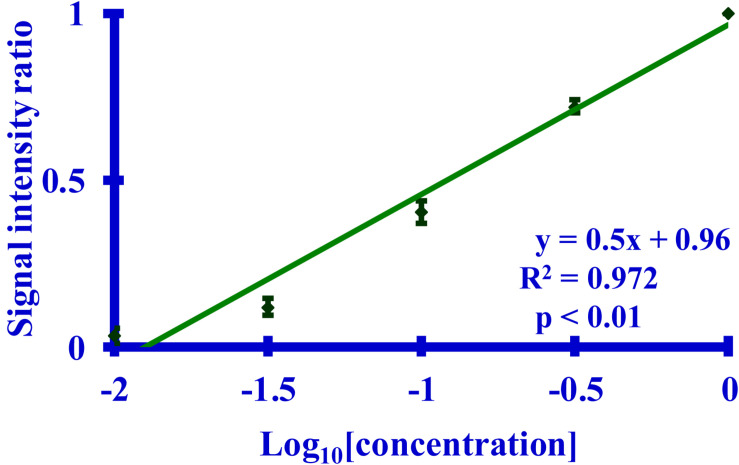
A graph of a Western blot-based relationship between the calculated signal intensity ratio derived from the binding of the 3F4 mAb to its MKHM epitope and the corresponding dilution of PrP 27-30. The primary mAb was 3F4. The calculated signal intensity is the ratio of the signal from a dilution to the undiluted starting material, as measured by densitometry. Five dilutions (n = 5 per dilution) of PrP 27-30 (undiluted, 1:3.2, 1:10, 1:32, or 1:100) were used.